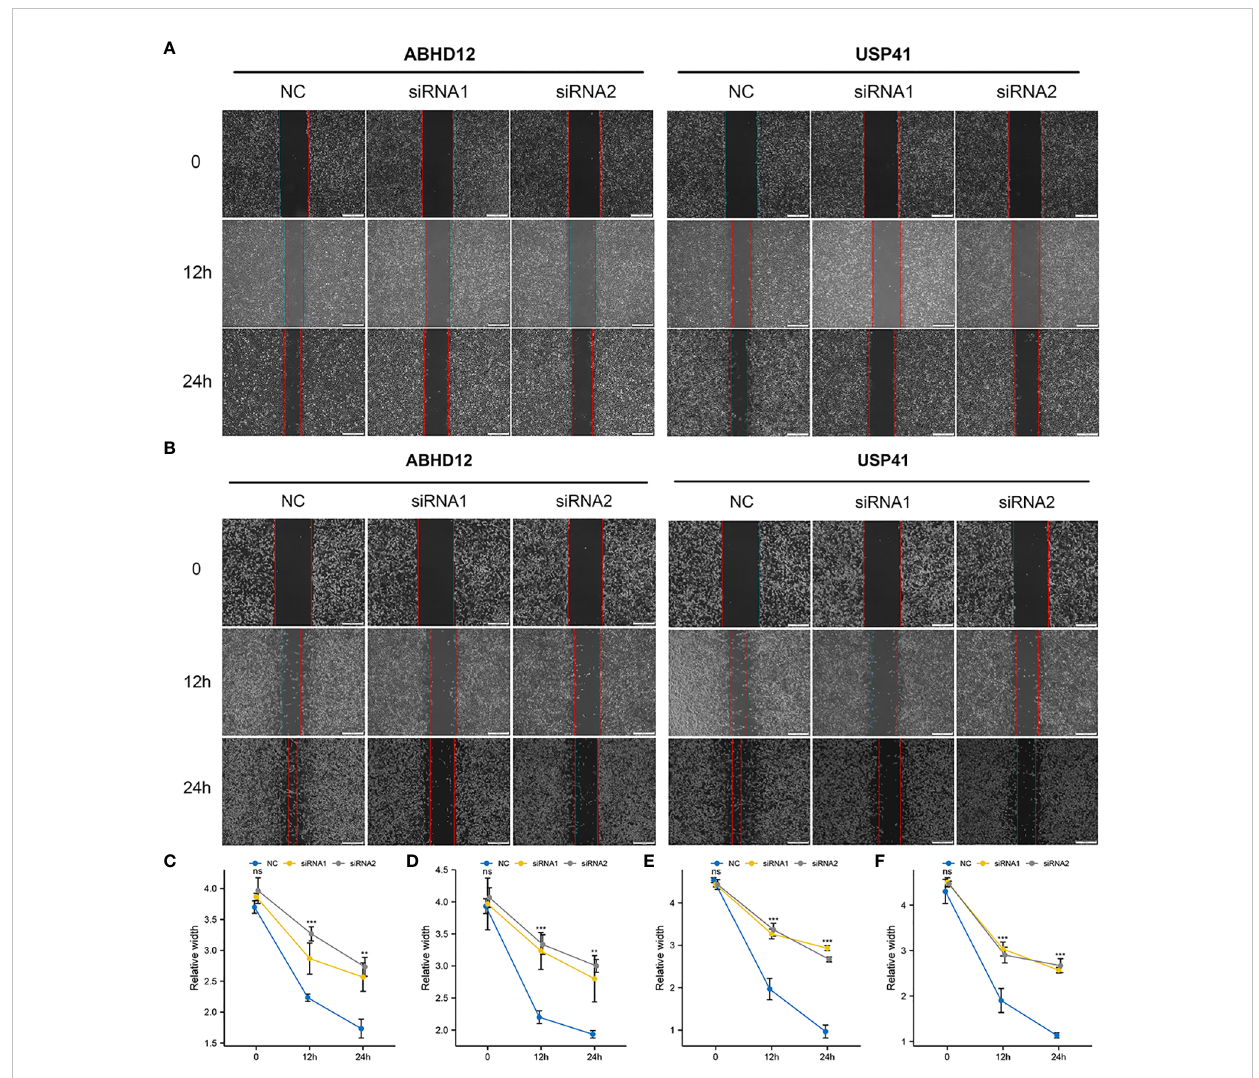
FIGURE 13 Effects of ABHD12 and USP41 on cell invasion. (A, C, D) Wound healing assay in MCF-7 cells. (B, E, F) Wound healing assay in MDA-MB-435S cells. ‘ ** ’ indicates P -value < 0.01; ‘ *** ’ indicates P -value < 0.001. "ns" represents non-signi fi